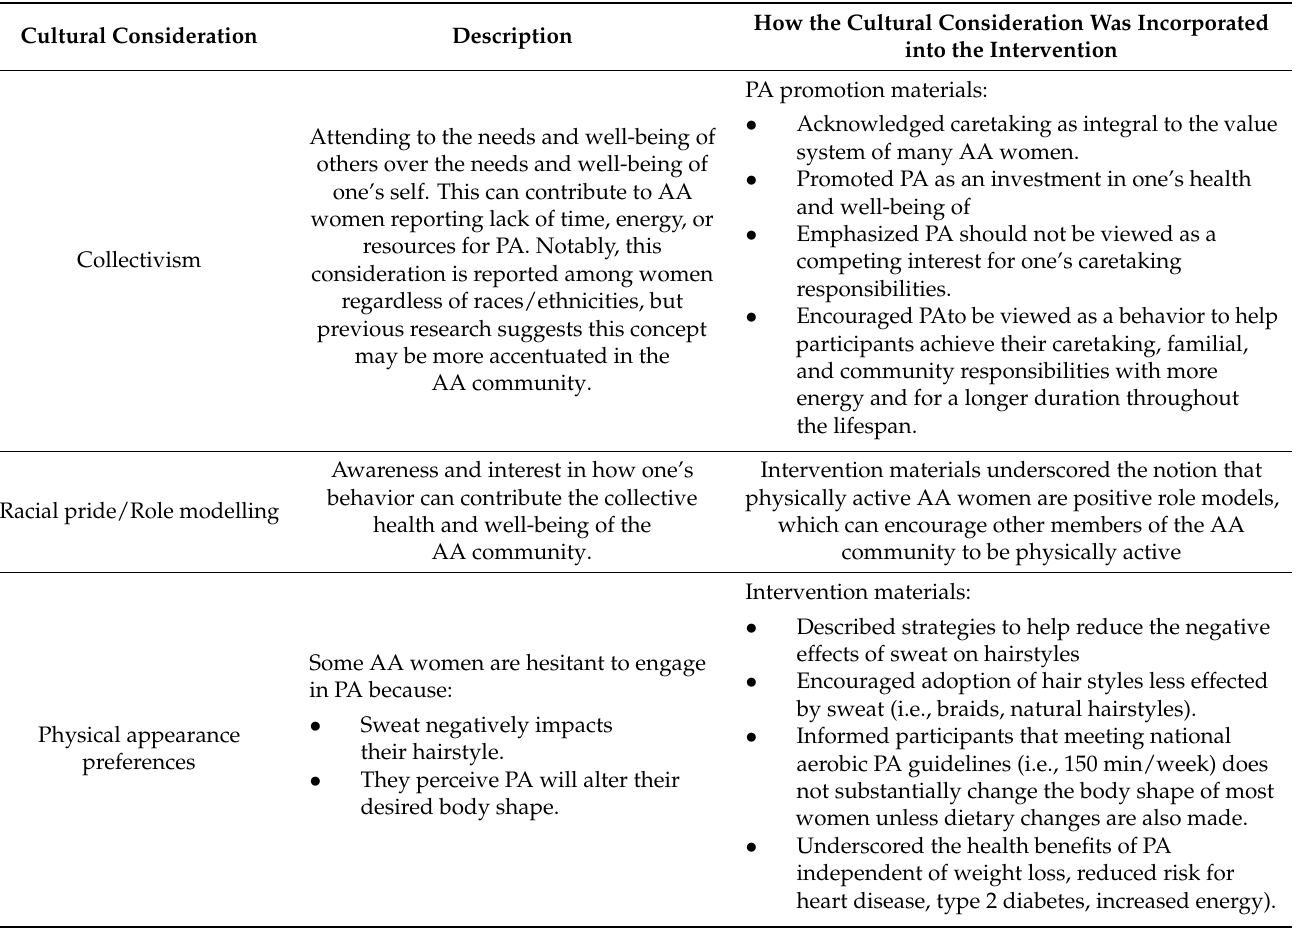
Table 3. Deep structure cultural considerations.